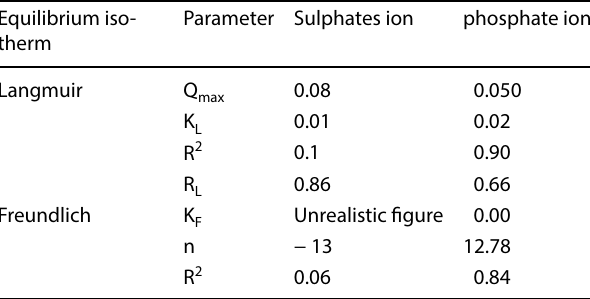
Table 7 Equilibrium isotherm parameters for adsorption of phos- phate and sulphate ions onto acid washed copper smelter slag Equilibrium iso- therm